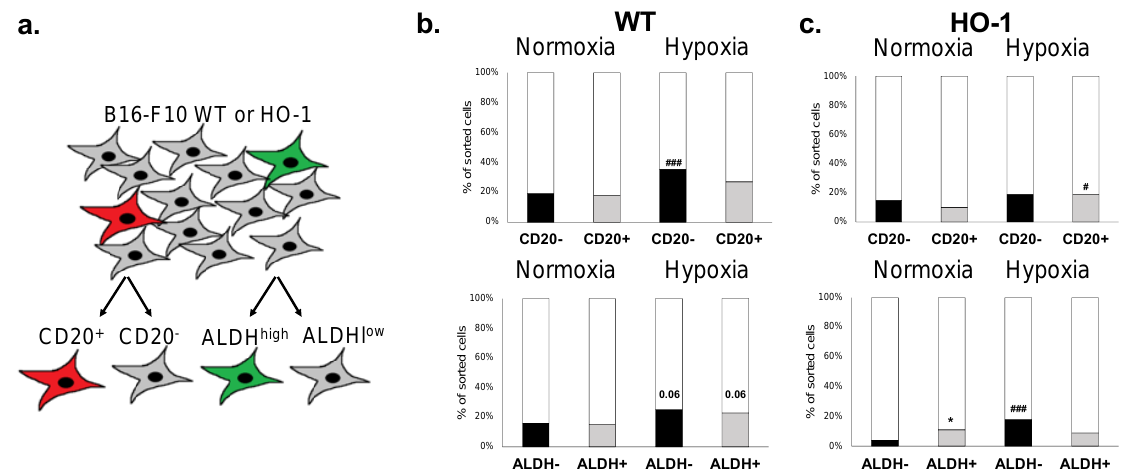
Figure 4. Formation of clones by single-cell sorted MIC + melanoma cells cultured in normoxia or hypoxia. ( a ) Scheme of sorting; comparison of MIC clone formation in ( b ) WT and ( c ) HO-1 cells 13 days after sorting (n = 116 – 216, Fisher exact test; * p < 0.05 versus WT-Luc cells, # p < 0.05, ### p < 0.001 versus normoxia).